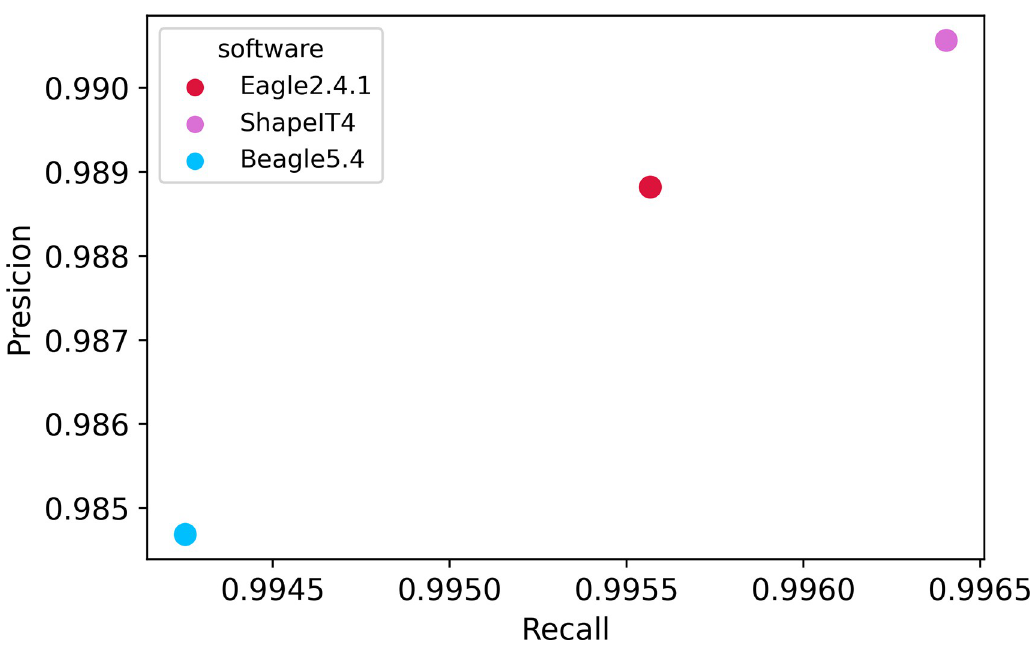
Fig 4. Precision and recall evaluation of phasing softwares Beagle5.4, ShapeIT4, and Eagle2.4.1. Precision and recall were evaluated using 540 trio children in the 1000GP-30x reference panel. Trios were selected and phased using trioPhaser software to ensure the highest accuracy and then the children were used as ground truth for the comparison. ShapeIT4 (pink dot) got the highest scores over Eagle2.4.1 and Beagle5.4 respectively.